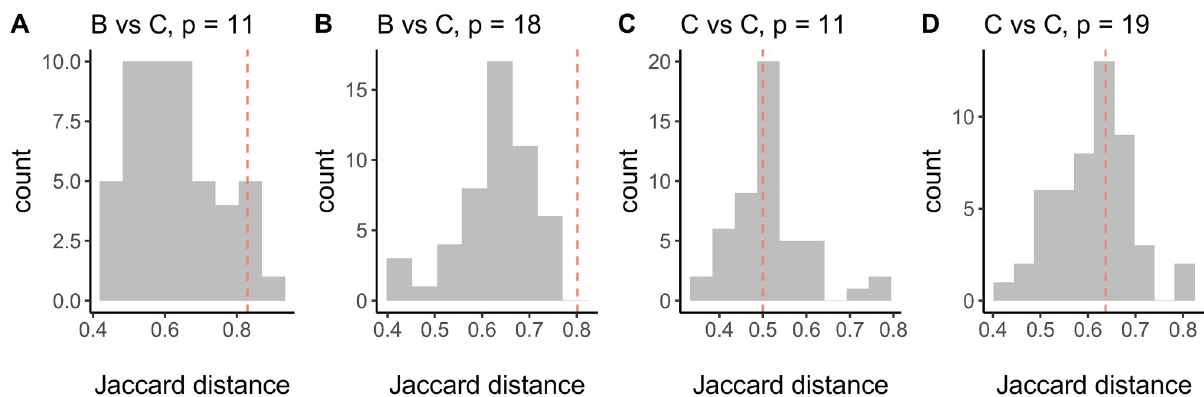
Fig 5. Empirical null distribution of pairwise Jaccard distances estimated by permuting group labels. Displayed are the histograms of Jaccard distances for the comparison of subtypes B and C for H-CBN2 posets with A 11 mutations and B 18 mutations, as well as the histograms of Jaccard distances for the comparison of two data sets for subtype C for H-CBN2 posets with C 11 mutations and D 19 mutations. Vertical dotted lines indicate the distance between the CBNs obtained from the observed data.